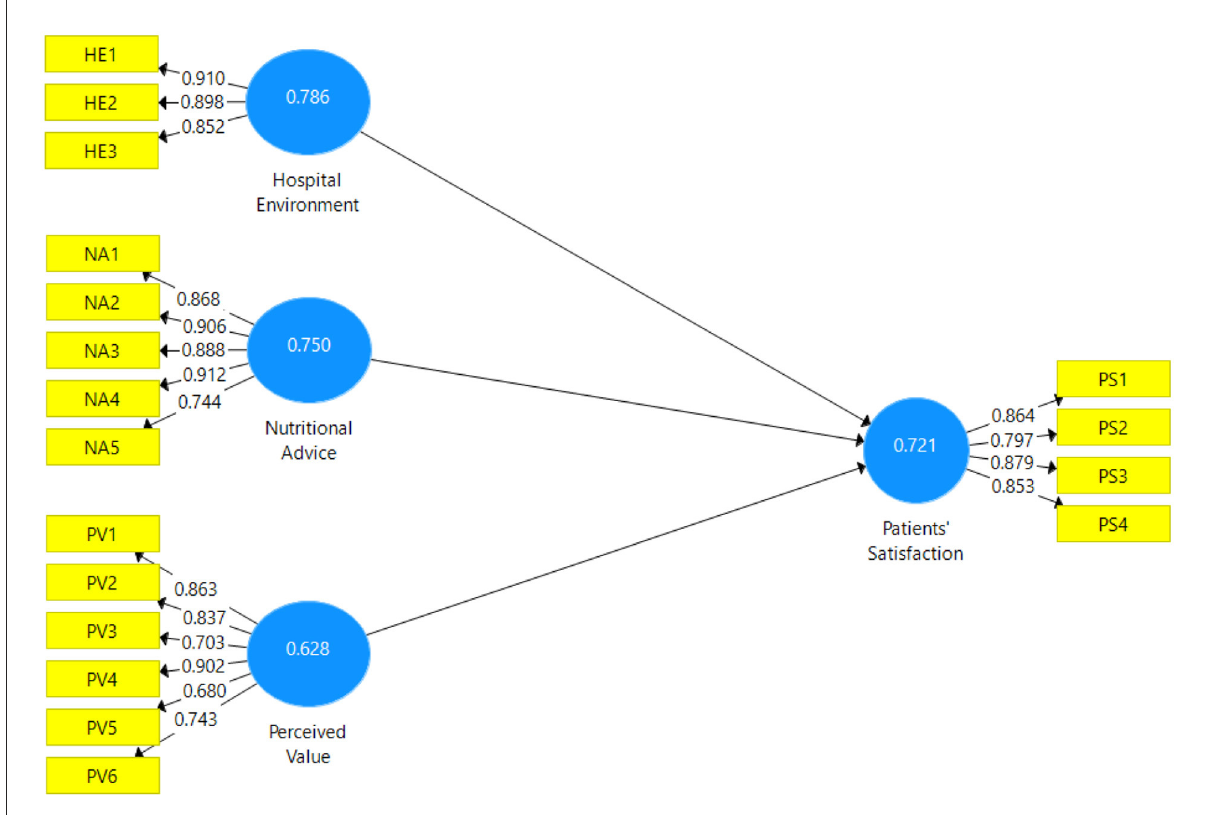
FIGURE3 Measurement model.